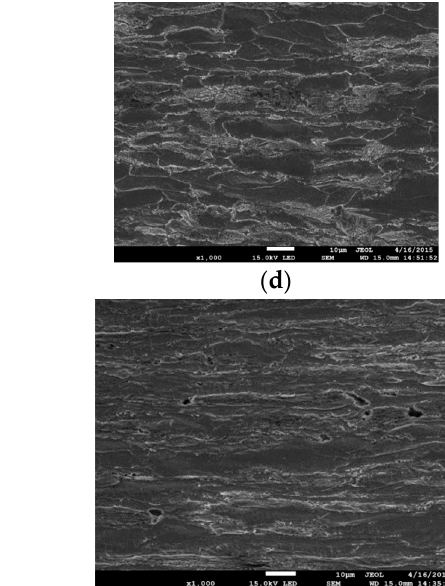
Figure 3. Deformed microstructure of S355 steel at different distance from the fracture plane: ( a ) 17 mm (undeformed material); ( b ) 7 mm; ( c ) 4 mm; ( d ) 2 mm; and ( e , f ) 0.1–0.2 mm.